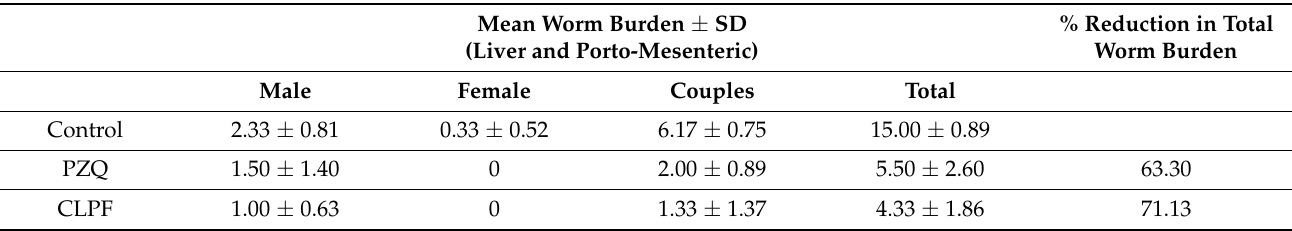
Table 5. Effect of PZQ and CLPF (single dose 250 mg/kg four weeks post-infection) on worm load and sex in S. mansoni -infected mice euthanizedsix weeks post-infection.